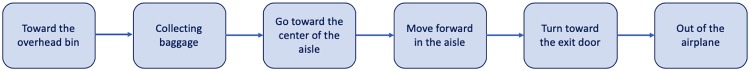
States of passengers while deplaning.